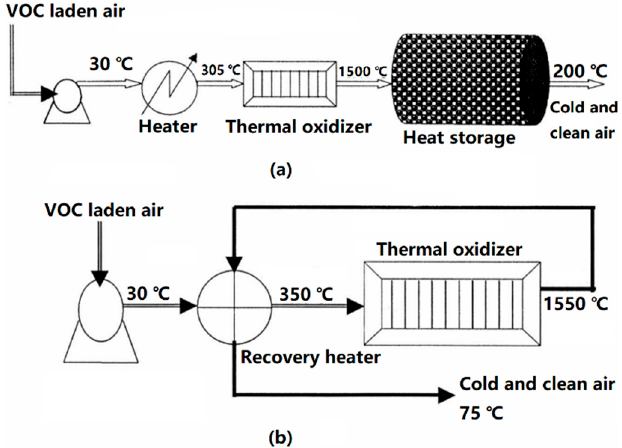
Figure 4. Schemes of thermal oxidation. ( a ) Regenerative thermal oxidation; ( b ) recuperative thermal oxidation. Reprinted with permission from [26], 2000, Elsevier Ltd.